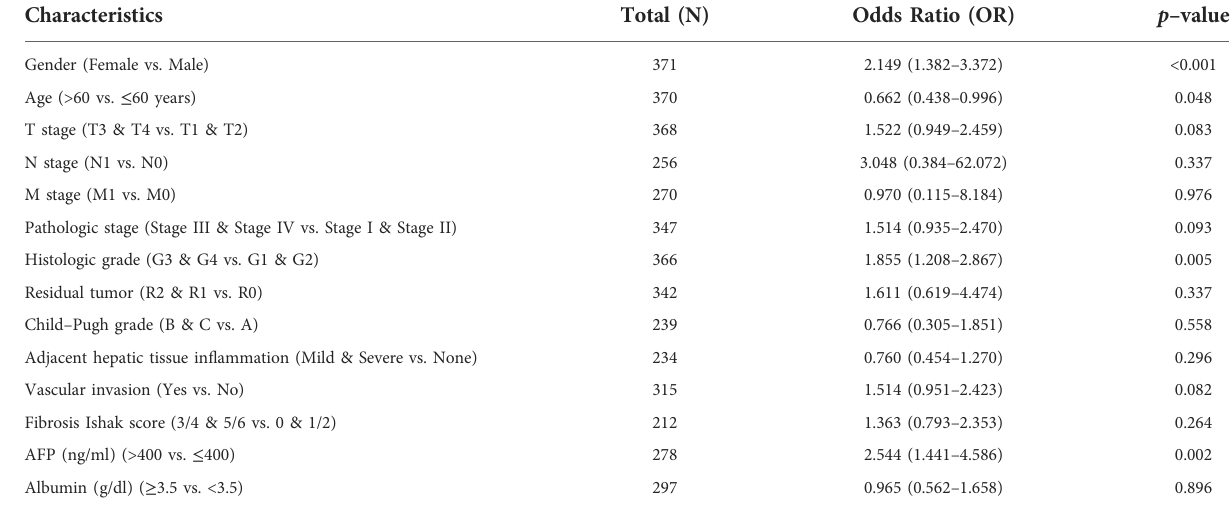
TABLE 2 BAIAP2L2 expression associated with clinicopathologic characteristics (logistic regression).